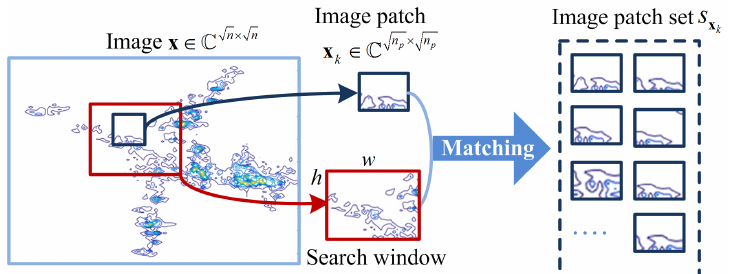
Figure 1. Extract each patch x k (as shown by the dark blue square) from image x and for each x k , search its l best similar patches in the search window (as shown by the red square) to compose the image patch set s x . k